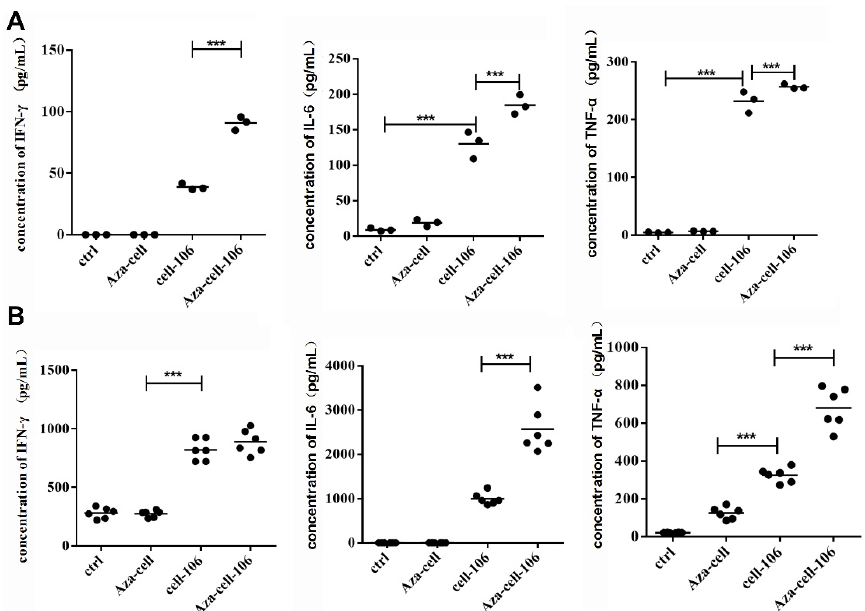
Figure 3. Cytokine release induced by Aza-BFcell-106 in vitro. ( A ). Aza-BFcell-106 stimulated the secretion of IFN- γ , IL-6, and TNF- α by splenic lymphocytes. ( B ). Aza-BFcell-106 stimulated the secretion of IFN- γ , IL-6, and TNF- α by BMDCs. Data are expressed as the mean ± SD ( n = 6) of one representative experiment. The same results were obtained in three replicate experiments. *** p < 0.001.